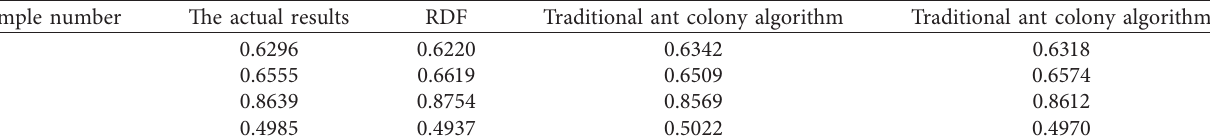
Table 3: The simulation results compared with the actual result.